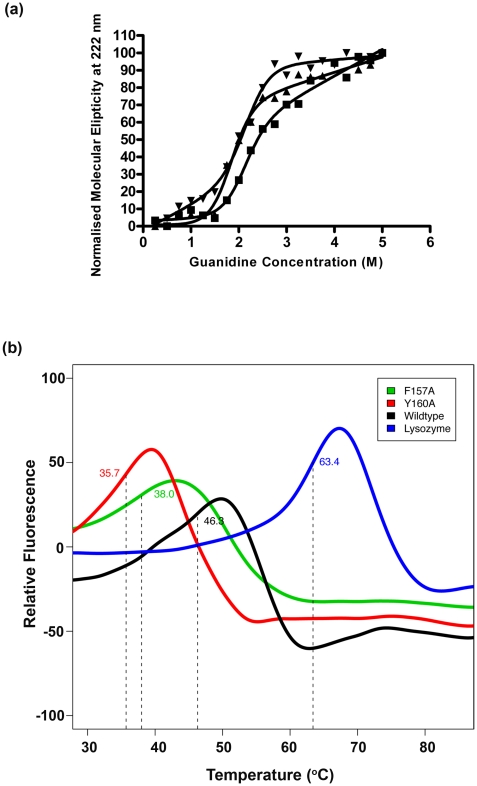
Stability studies of GSTM2-2 and GST-C variants measured by circular
dichroism (CD) and differential scanning fluorimetry.(a) Normalised molecular ellipticity at 222 nm as a function of guanidine
HCl concentration (0–5 M) as measured by CD experiments, GST-C
(■), Y160A (▼) and F157A (▲). (b) Differential scanning
fluorimetry profiles of GST-C wildtype (black), GST-C/Y160A (red),
GST-C/F157A (green) and hen egg-white lysozyme control (blue). Melting
temperatures (Tm) are denoted by vertical broken lines.